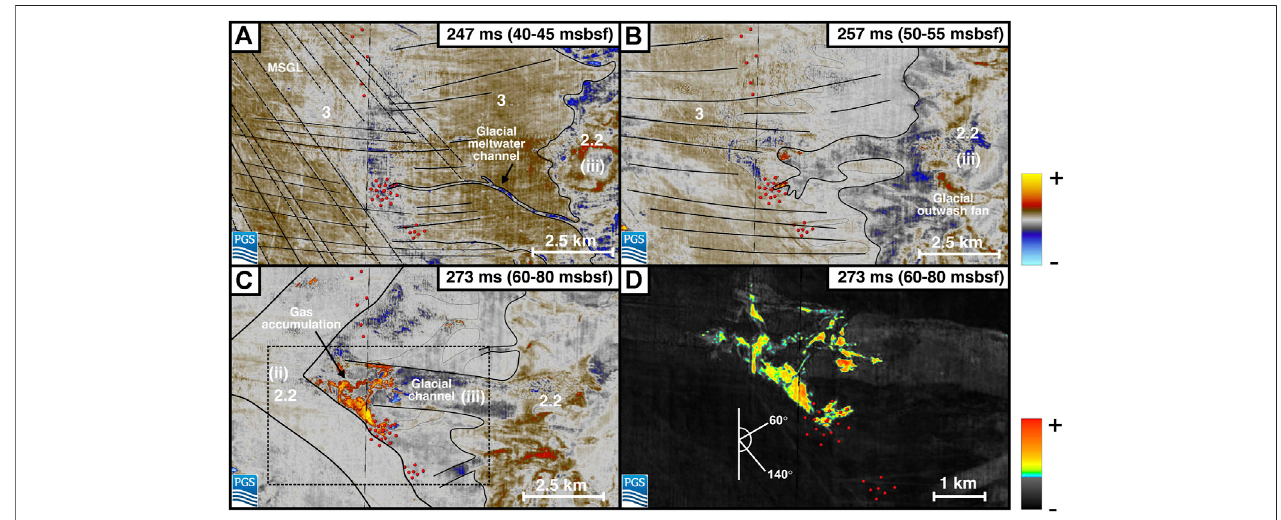
FIGURE 11 | Time slice amplitude maps that provide a regional context for the presence and orientation of the shallow gas. 3D seismic re fl ection data is used to generate surface amplitude maps at three time intervals: (A) 40 – 45 ms (B) 50 – 55 ms and (C, D) 60 – 80 ms two way travel time below sea fl oor. Black solid lines display boundariesbetweenseismicunitsorhighlightkeygeologicalfeatures. (D) RMSamplitudemap,acquired overatimewindowof ± 2.5 msTWT,highlightingthepresence andorientationofgaschargedsediments;twodominantorientationsof60 ° and140 ° areobserved,whichcorrespondtotheorientationofglacialchannelsandthe stratigraphic juxtaposition of seismic units S2.2 ii and S2.2 iii, respectively.